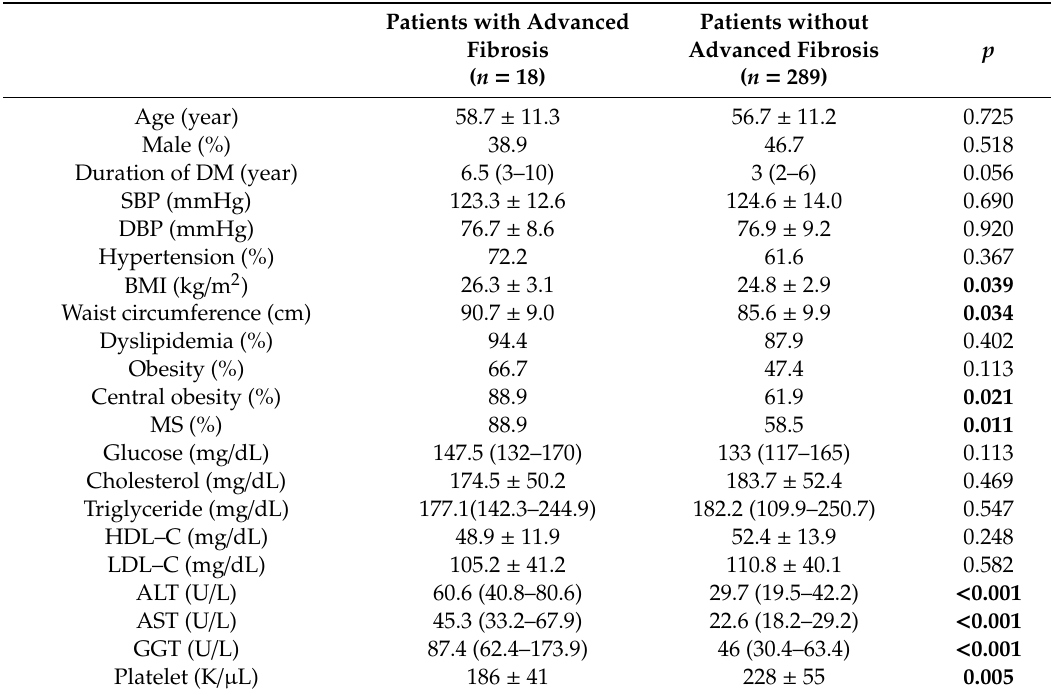
Table 2. Features of patients with and without advanced fibrosis on transient